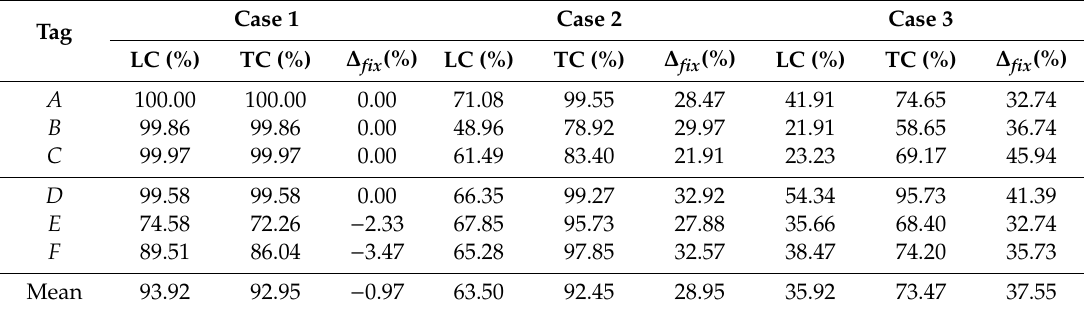
Table 6. Comparison of the ambiguity fixing rates between LC and TC under different scenarios and the corresponding differences.